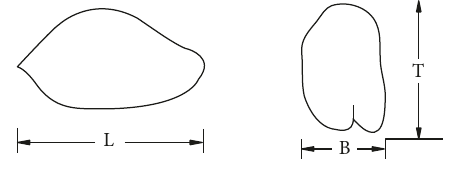
Figure 2: Size of wheat grain.